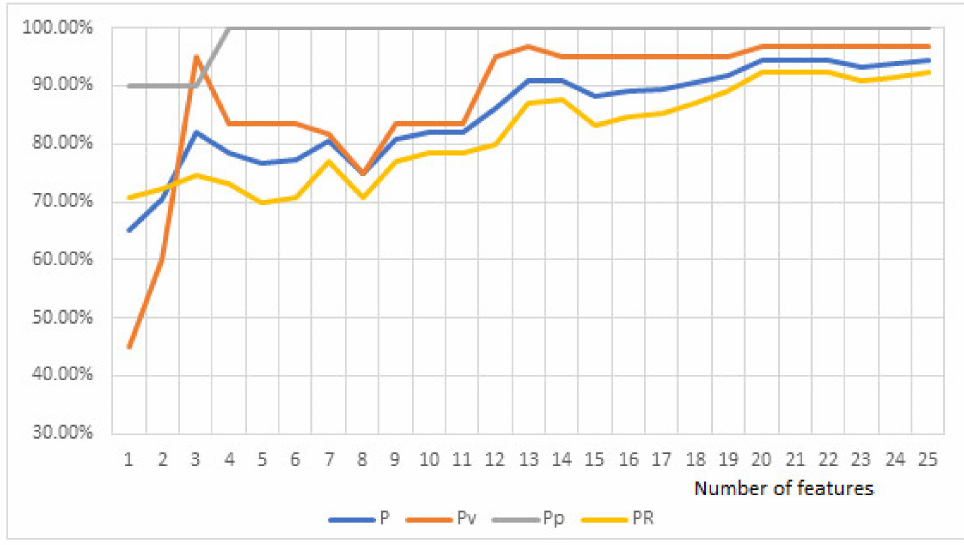
Figure 5. Feature evaluation for VPR scheme.